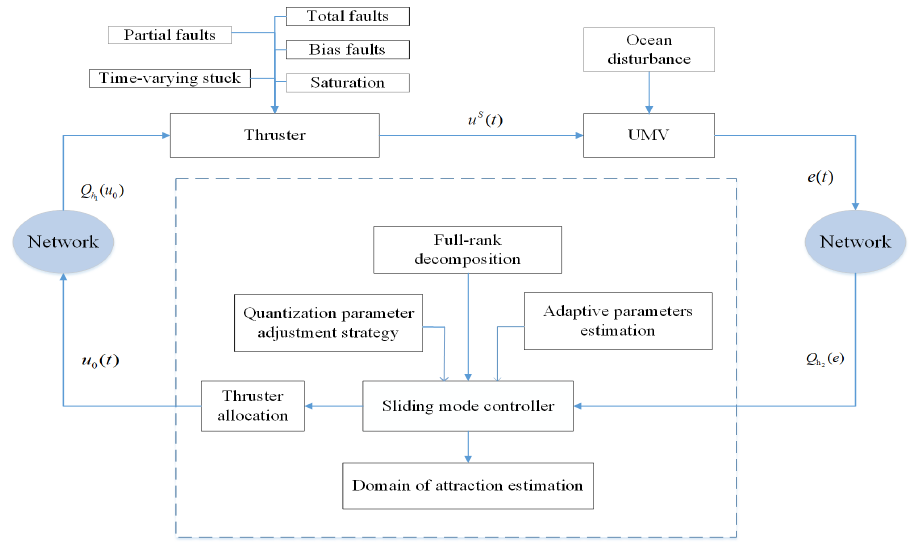
Figure 2. Structure diagram of sliding mode fault-tolerant method with signal